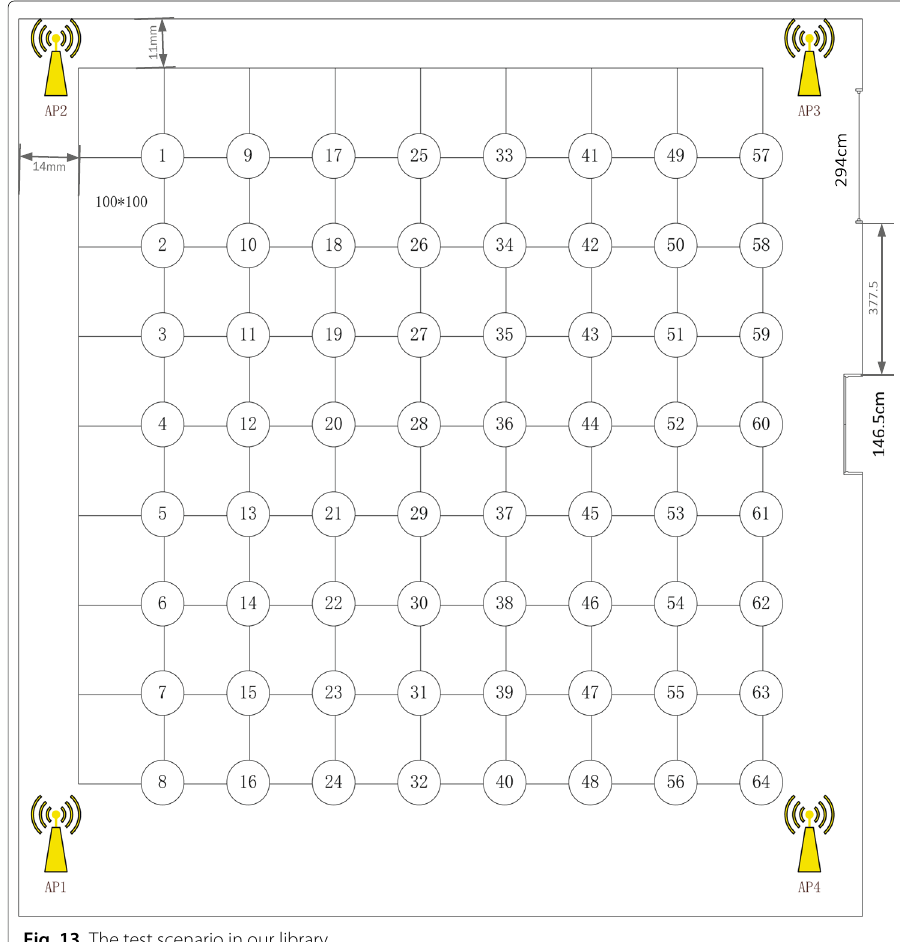
Fig. 13 The test scenario in our library